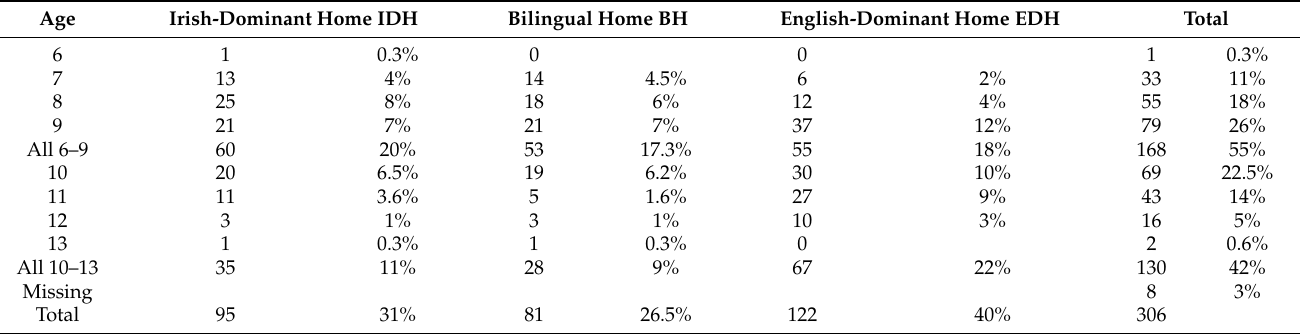
Table 1. Child sample by language background and age.